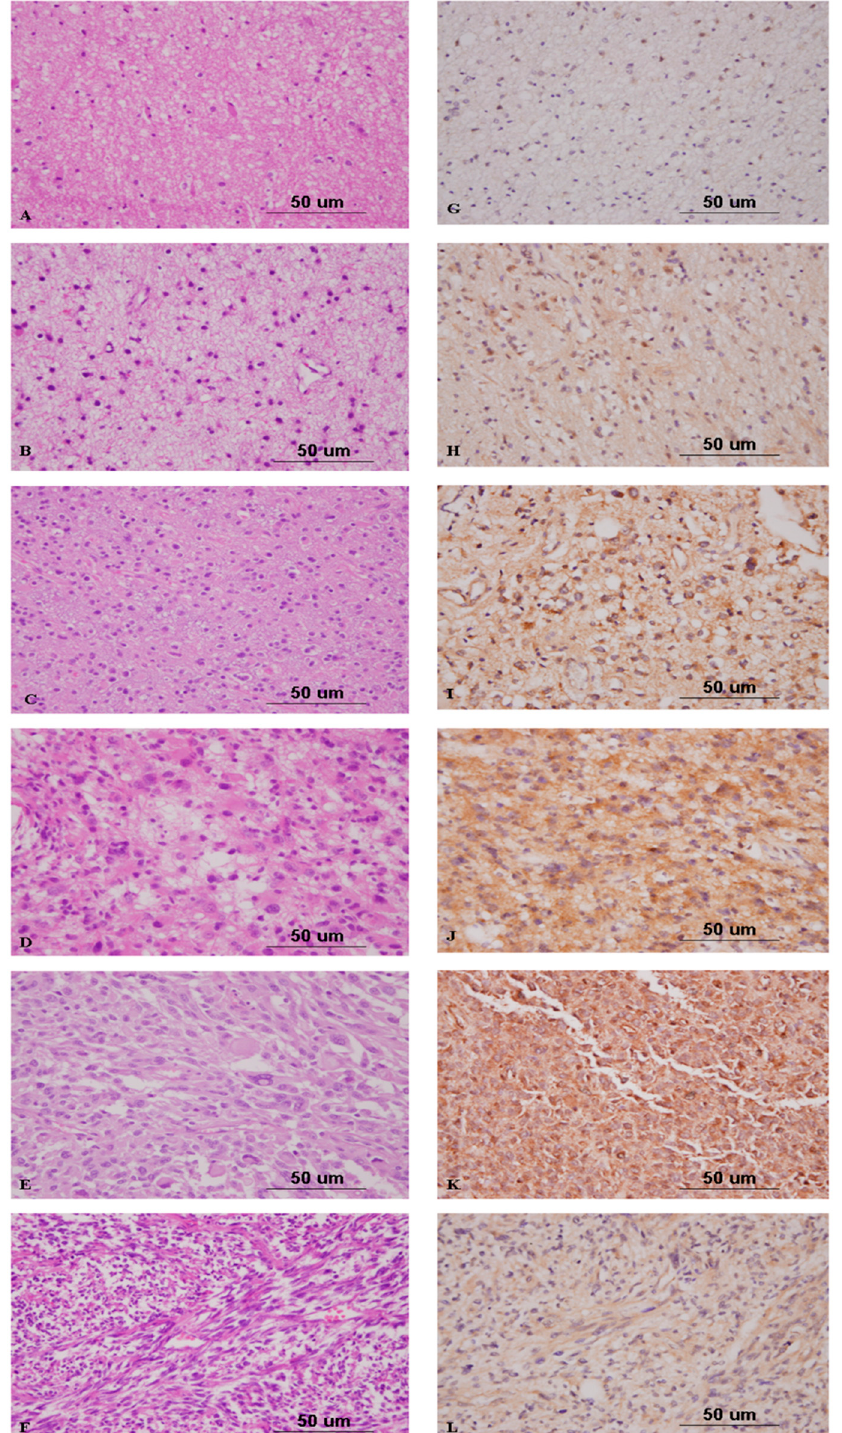
Figure 3. Hematoxylin and eosin staining of non-neoplastic brain tissue ( A ); pilocytic astrocytoma ( B ); diffuse astrocytoma ( C ); anaplastic astrocytoma ( D ); glioblastoma multiforme ( E ); and gliosarcoma ( F ); and immunohistochemical analysis of Nrf2 in non-neoplastic brain tissue ( G ); pilocytic astrocytoma ( H ); diffuse astrocytoma ( I ); anaplastic astrocytoma ( J ); glioblastoma multiforme ( K ); and gliosarcoma ( L ) (original magnification ×400).